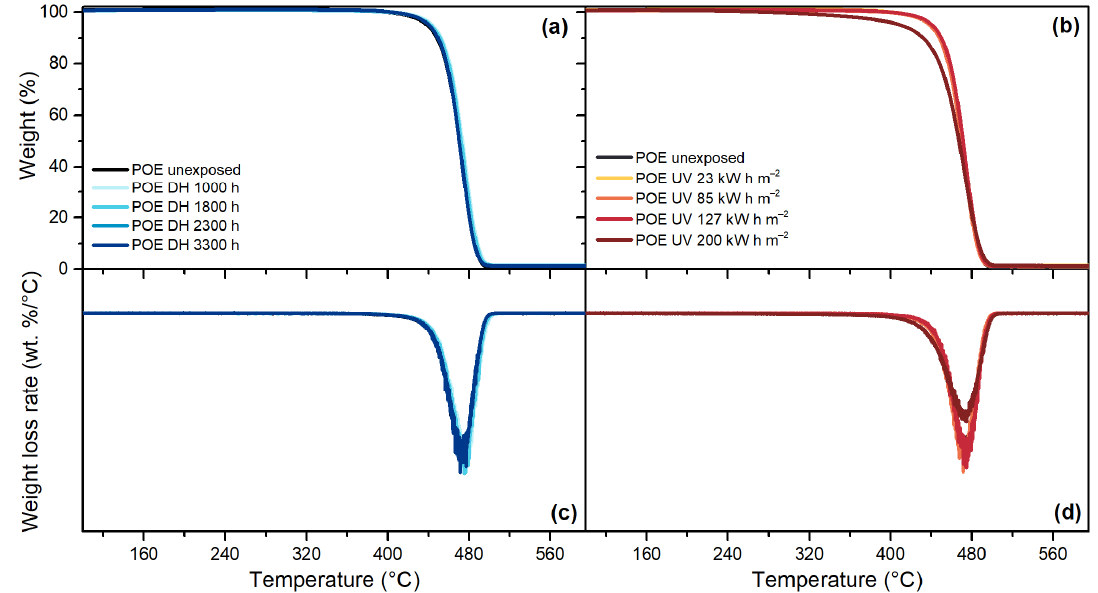
Figure 14. Residual weight over temperature during TGA measurements of POE after the exposure to DH test ( a ). Residual weight over temperature during TGA measurements of POE after the exposure to UV test ( b ). Weight loss rate over temperature of POE samples exposed to DH test ( c ). Weight loss rate over temperature of POE samples exposed to DH test ( d ).